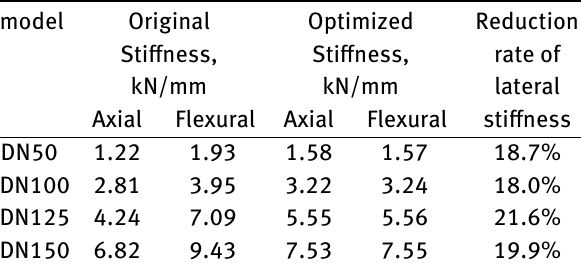
Table 5: Optimization results of axial and lateral stiffness. model